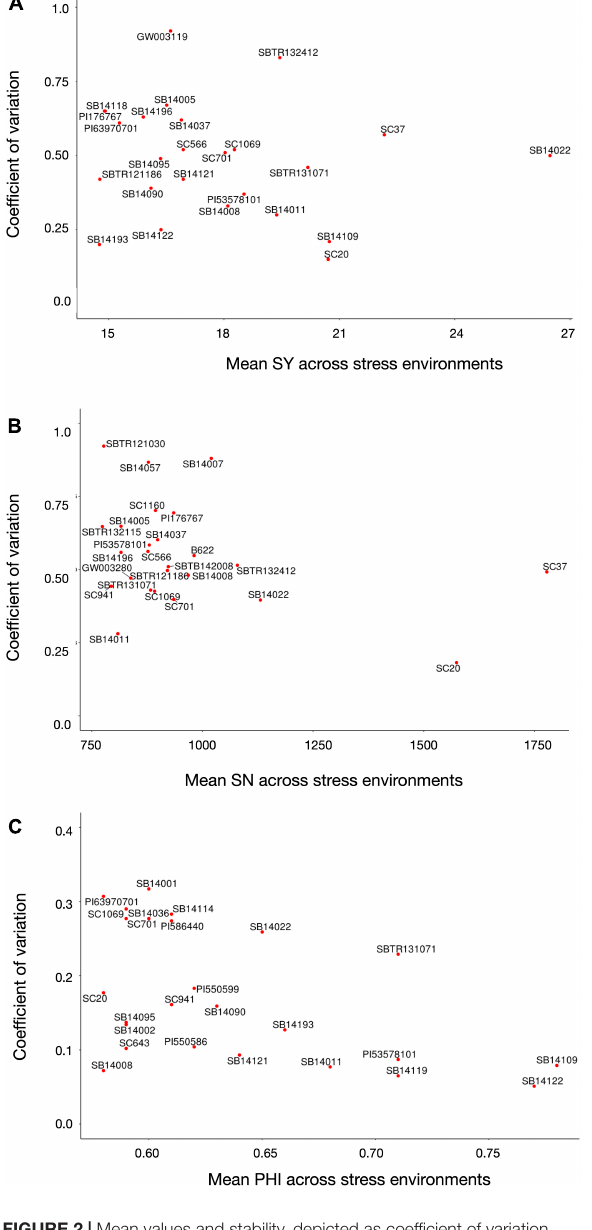
FIGURE 2 | Mean values and stability, depicted as coefficient of variation across the mean trait values of a line in each environment (low values indicate a higher stability), of the top 5% ( n = 12) best performing genotypes with complete dataset over all four stress environments for (A) seed yield per panicle, (B) seed number, and (C) and